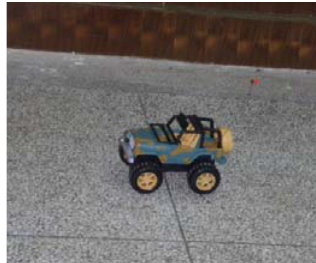
Figure 9. The wireless remote car.